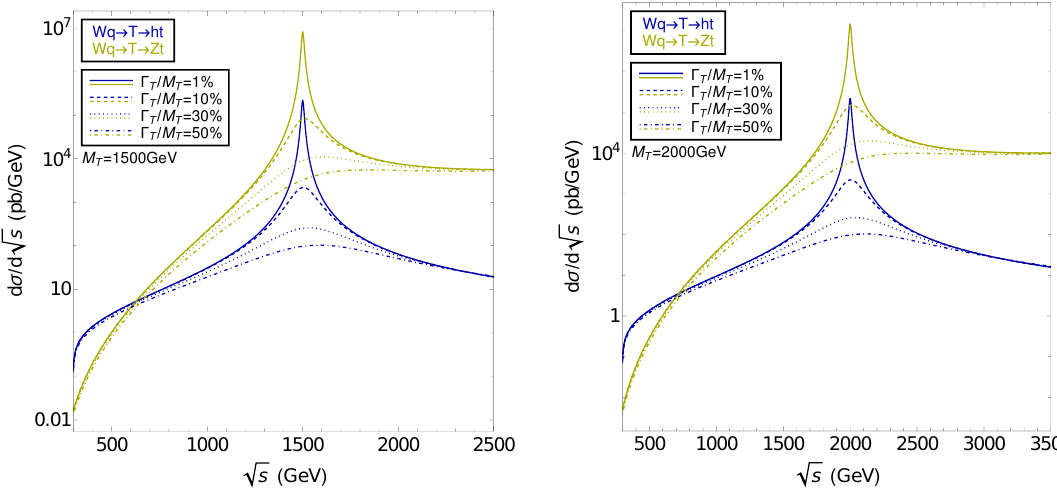
Figure 4 . Partonic cross section for the Wq → ht (blue) and Wq → Zt (yellow) processes, that both proceed via the s -channel exchange of a vector-like quark T . We depict the dependence of the √ cross section on the partonic centre-of-mass energy s , for different values of the Γ T /M T ratio. We consider vector-like quark setups with M T = 1500 GeV (left panel) and 2000 GeV (right panel), and chiralities of the T couplings that are chosen left-handed and fixed as in eq. (3.7) to reproduce the branching ratio relation of eq.